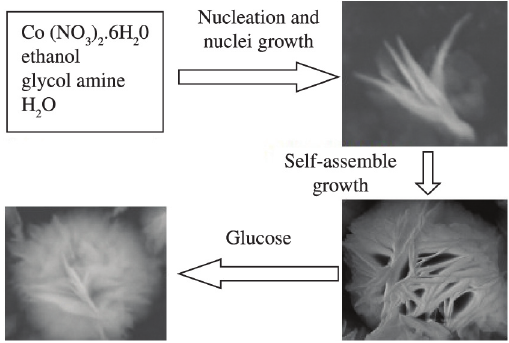
Figure 3. Schematic illustration of the morphology evolution process of the flower-like Co(OH)